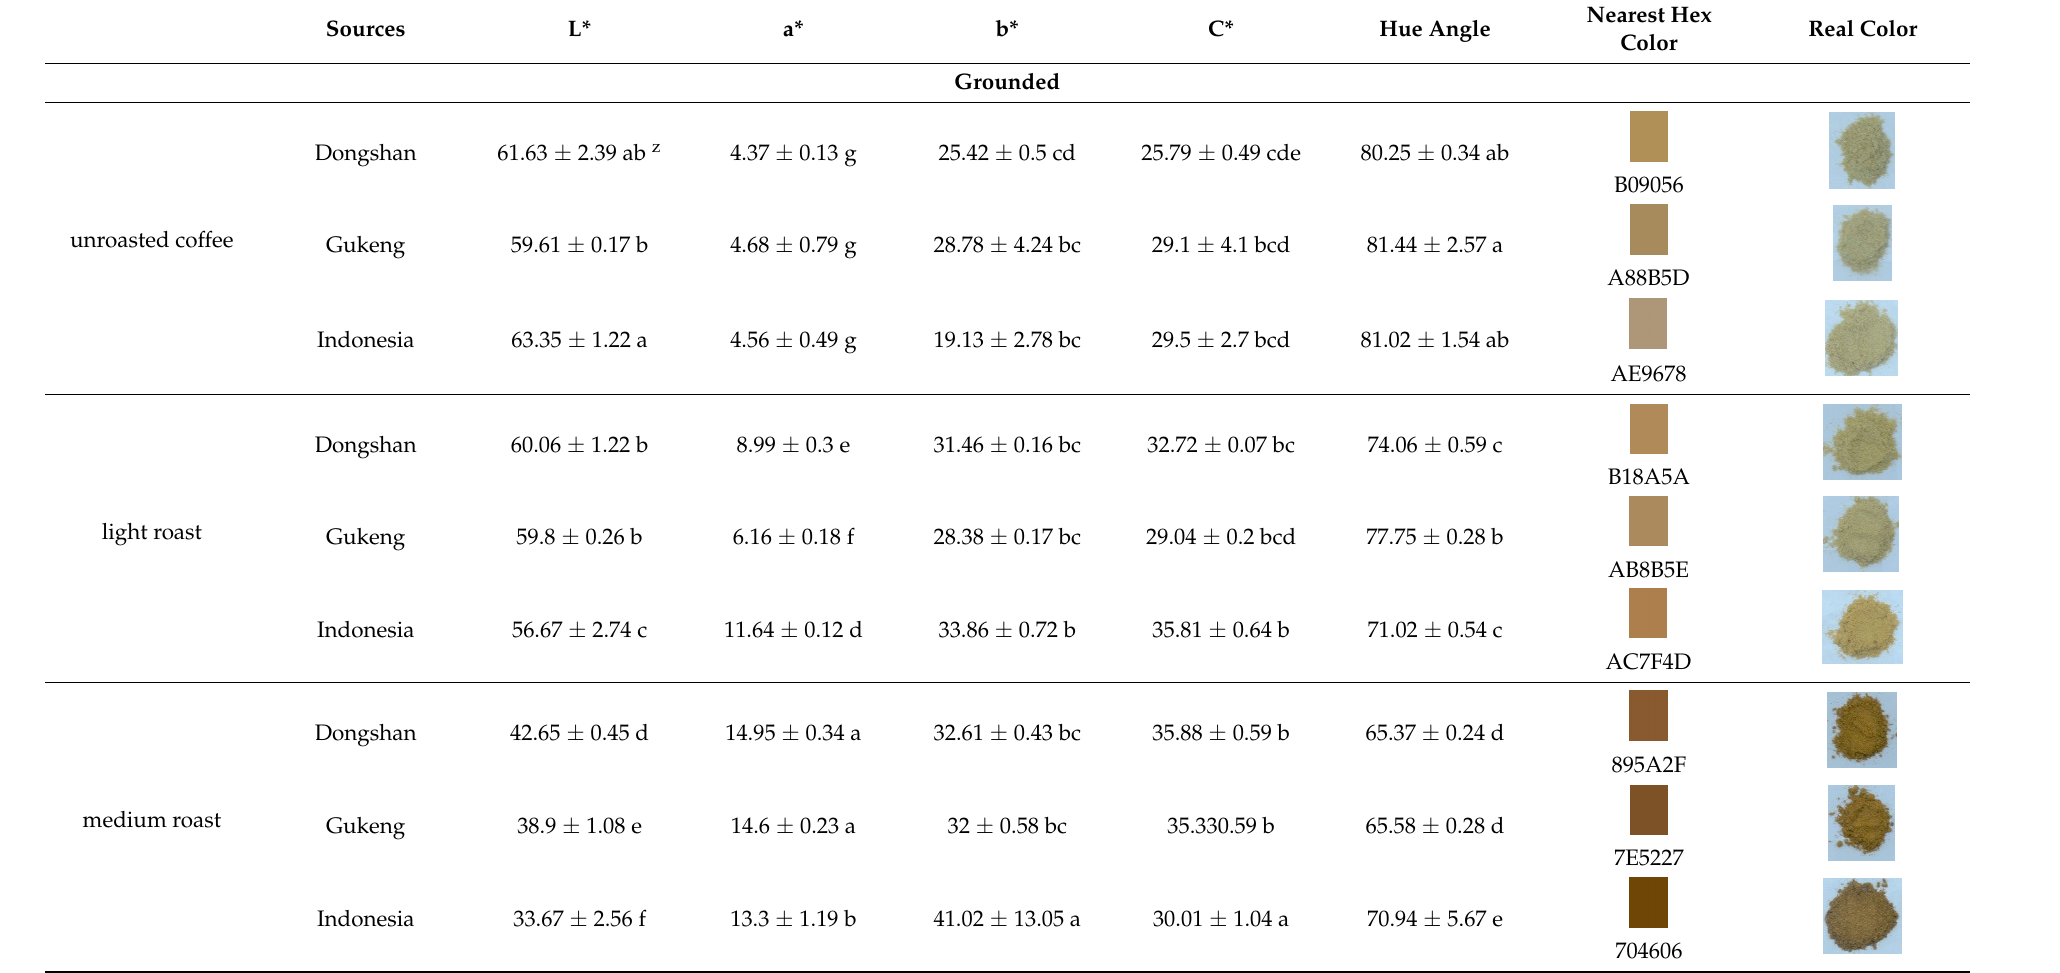
Table 2. CIE L*, a*, and b* values of different sources and roasting degrees of ground coffee.